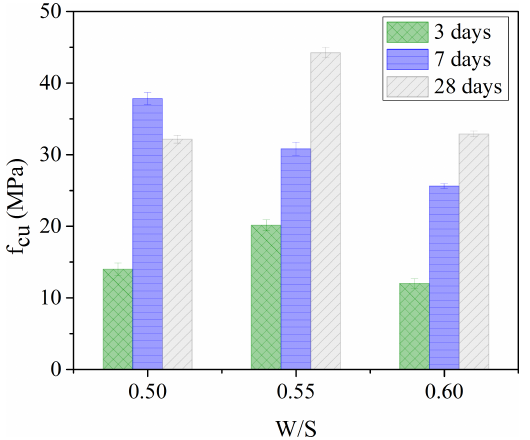
Figure 10: Effect of W/S ratio on compressive strength